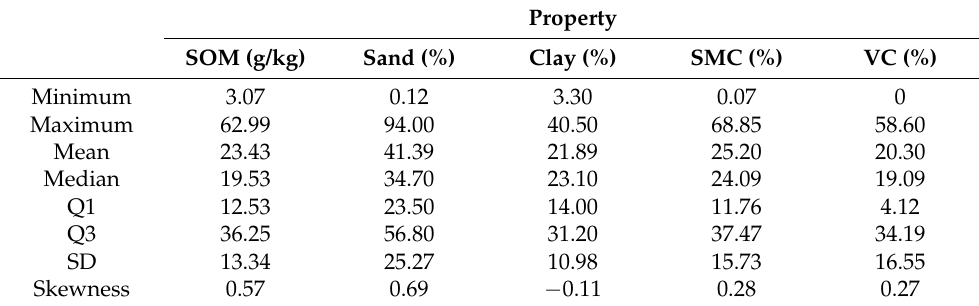
Table 1. Summary statistics of soil properties and vegetation coverage ( n = 11,165).